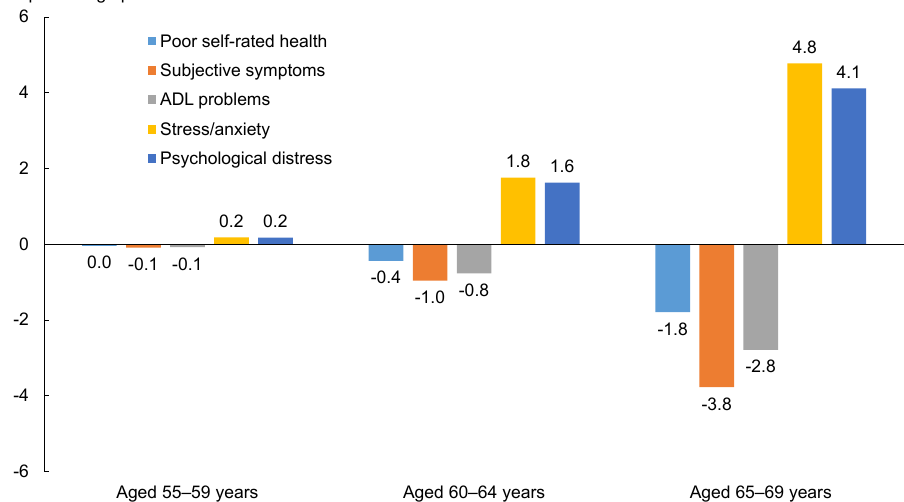
Figure 2. Simulated impacts on health outcomes of raising the eligibility ages for mandatory retirement and public pension to 70 years ADL, activities of daily